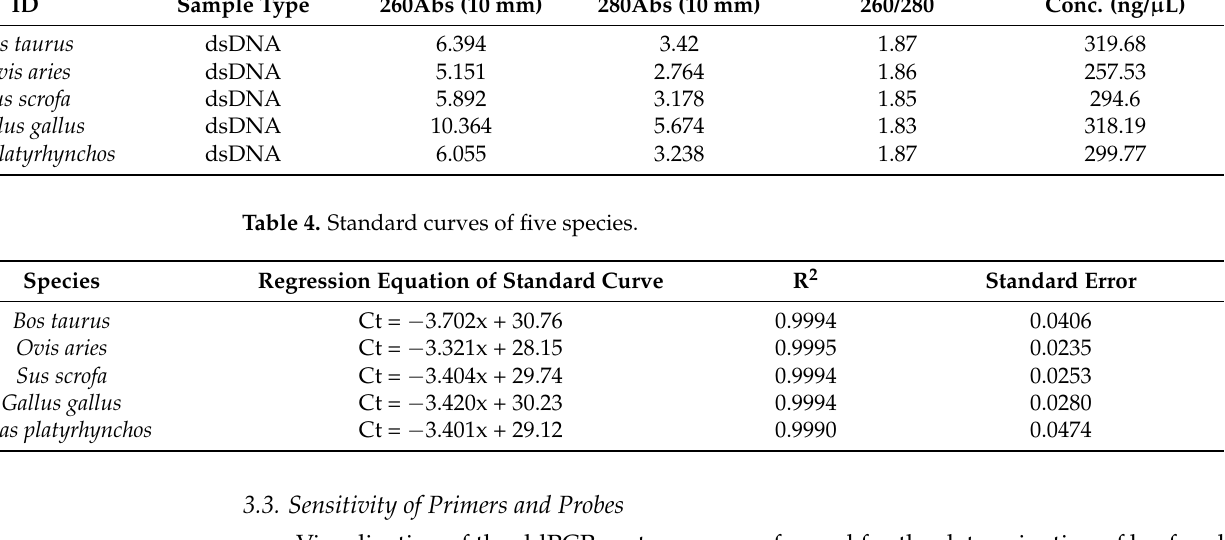
− 0.06 Table 6. Measured values of ddPCR for pork, chicken and duck. DNA Template